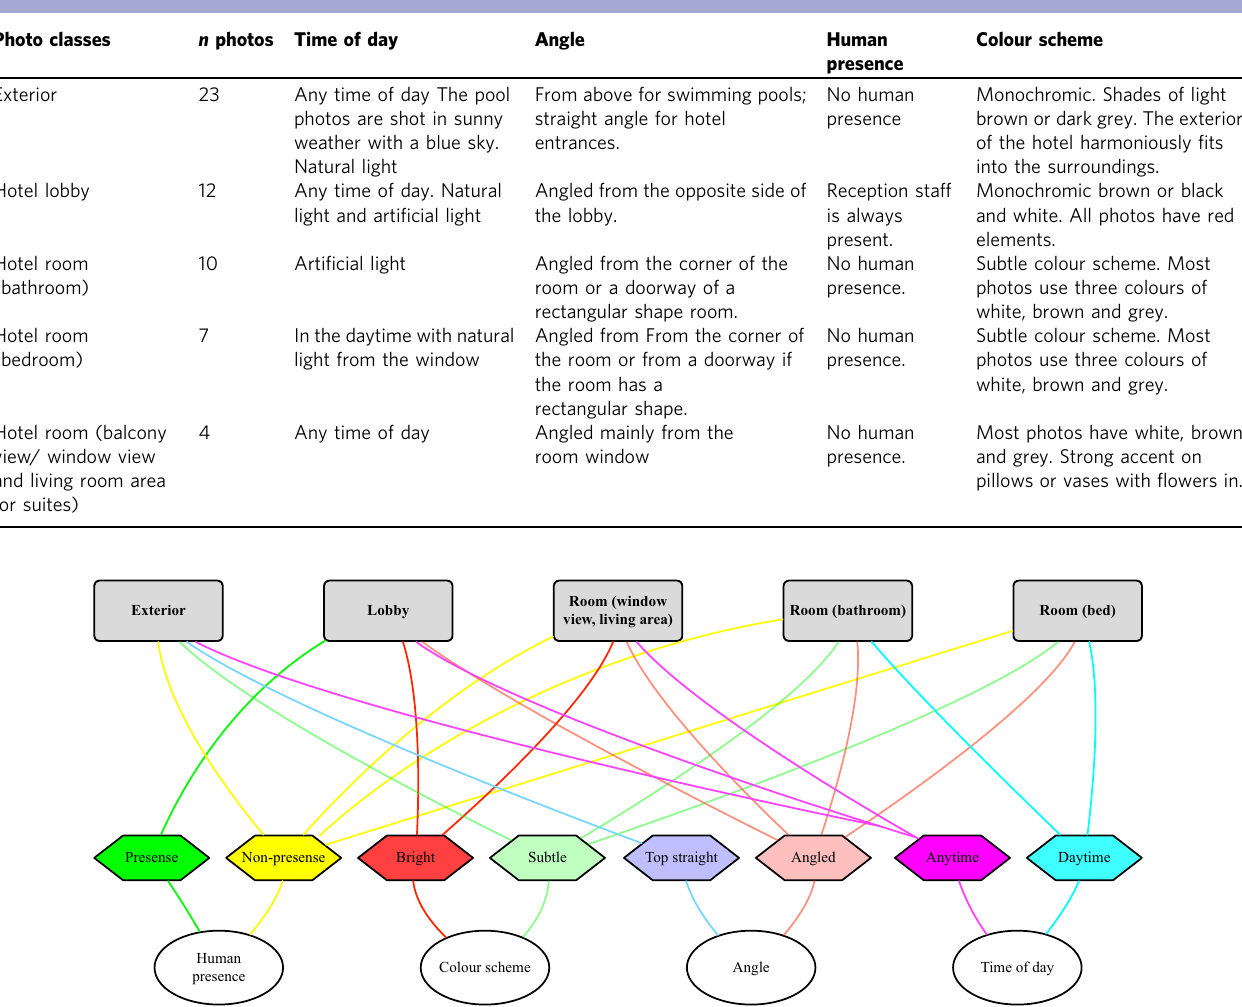
Fig. 5 Fuzzy cognitive map of the ‘ selling ’ hotel photography image properties. Grey rectangles indicate hotel photo composition categories, coloured hexagons represent hotel photography technique variations to be applied with composition rules, and white ovals point to the composition rules in hotel photography. Linking lines are coloured to simplify understanding of how the composition rules and their varied techniques can be applied in shooting each hotel photo composition